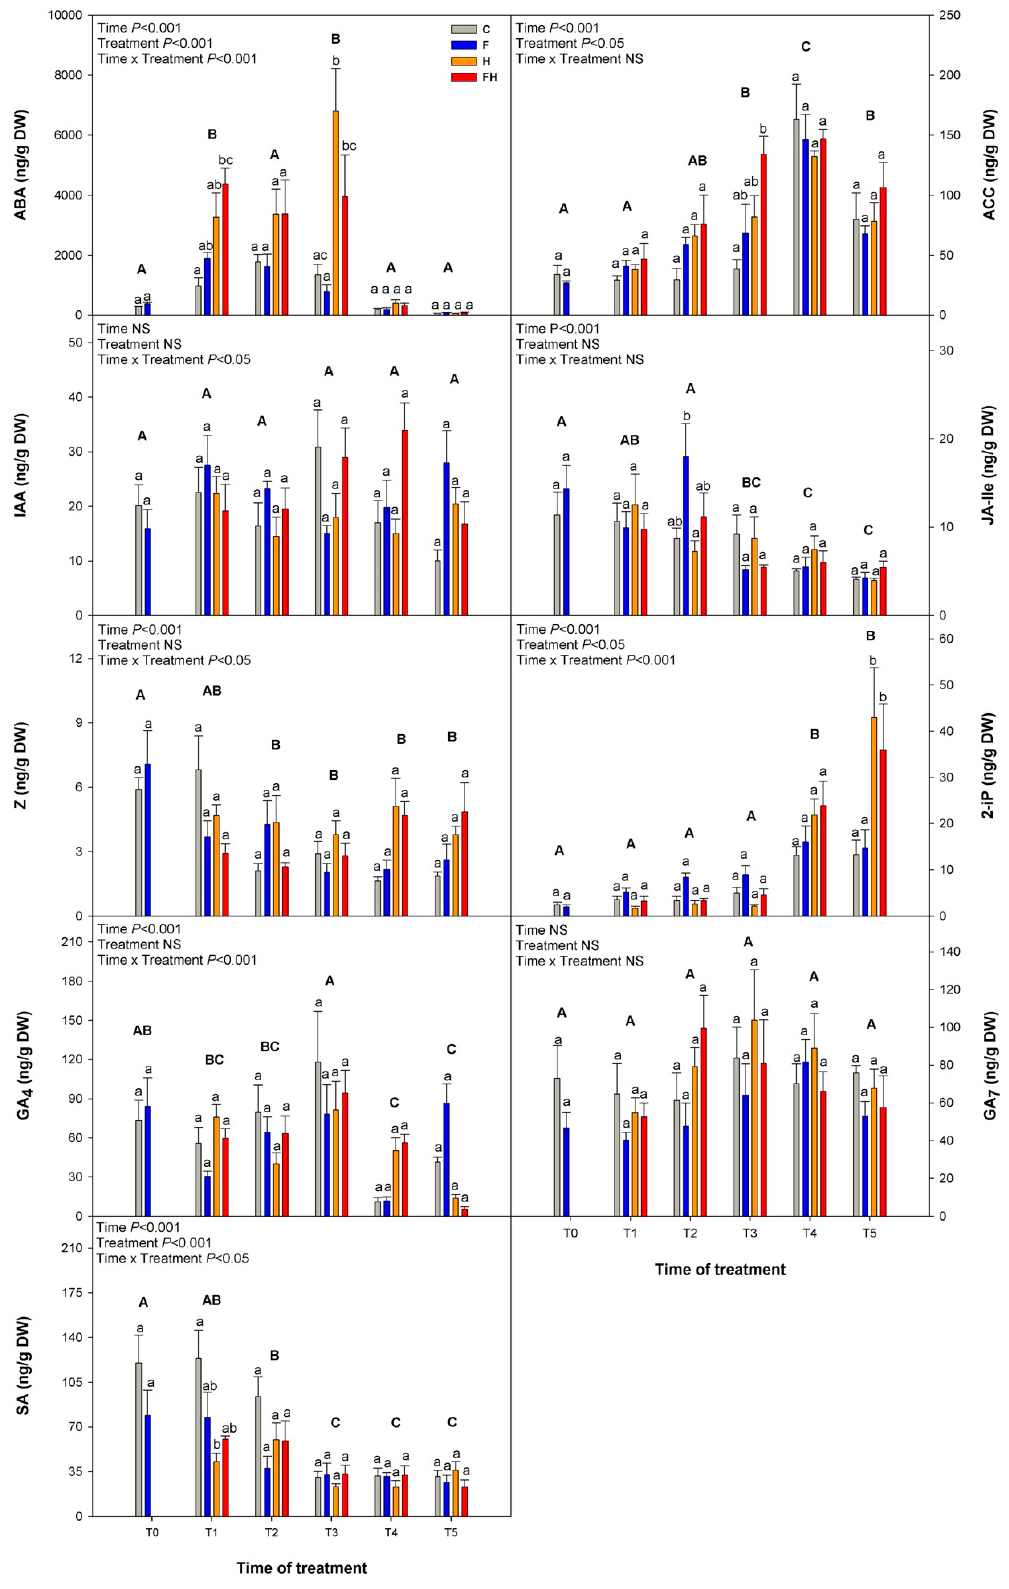
Figure 7. Hormone levels in berries samples (C, control; F, flooded; H, heatwave; FH, flooded plus heatwave). The results of the statistical analyses are reported within each chart along with the letter indicating statistically different values (uppercase for the timepoint and lowercase for the